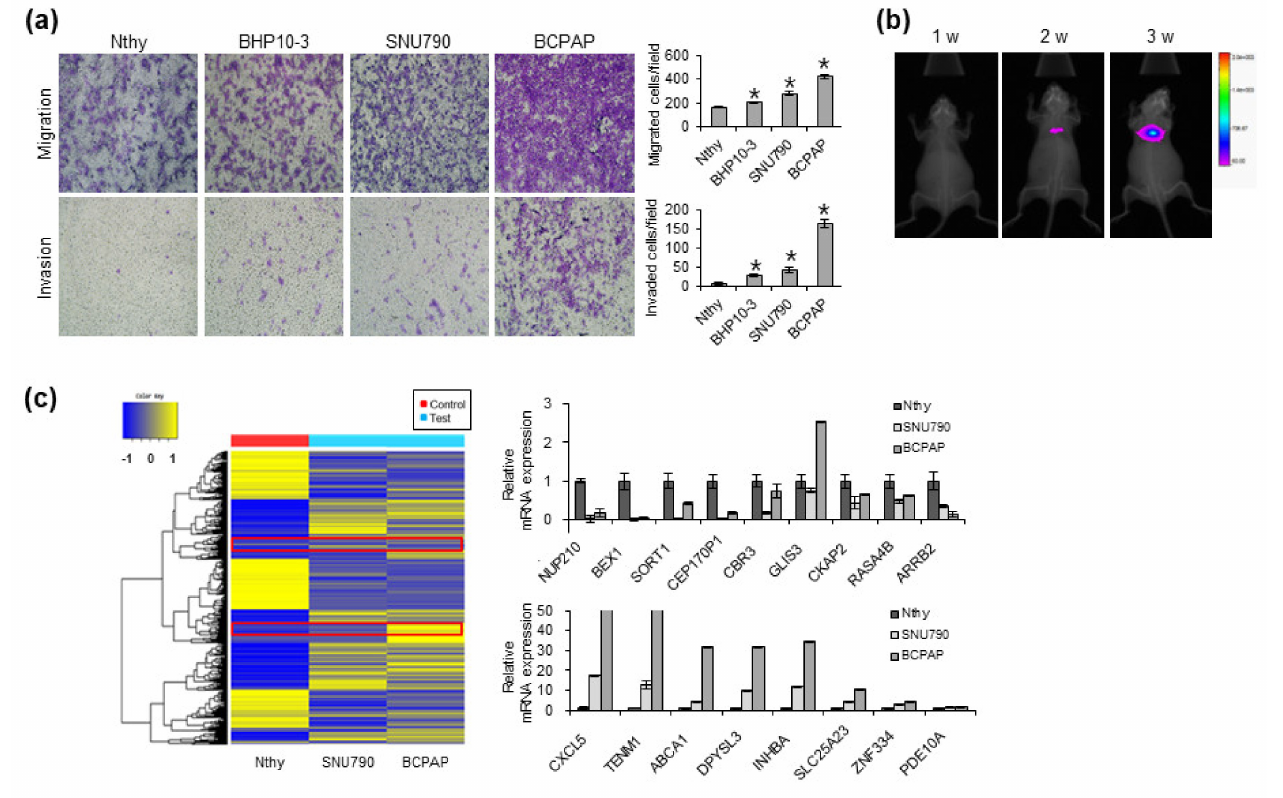
Figure 1. Characterization of papillary thyroid cell lines for metastatic capacity. ( a ) Migration (upper) and invasion (lower) by thyroid cells were analyzed and quantified. * p < 0.05 compared with Nthy cells (Student’s t -test). ( b ) Images of lung metastases that developed in the BCPAP cells in the tail vein injection models. The images were acquired using an IVIS imaging system. Representative luciferase signals captured in each group at the time of the initial injection, 1 week, 2 weeks, and 3 weeks after cell injection, are shown. ( c ) Heatmap generated from the microarray analysis of indicated thyroid cells showing the differential expression between the three cells. The mRNA levels of indicated candidate targets in the thyroid cell lines were validated via qRT-PCR. The data represent the mean ± SD of triplicate measurements. * p < 0.05 vs. Nthy cells based on two-tailed Student’s t